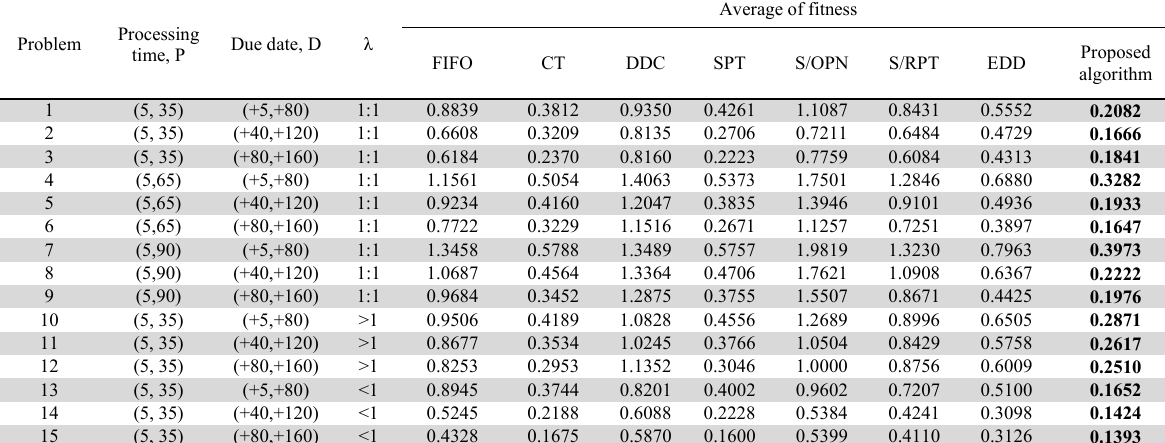
Average of fitness results from different